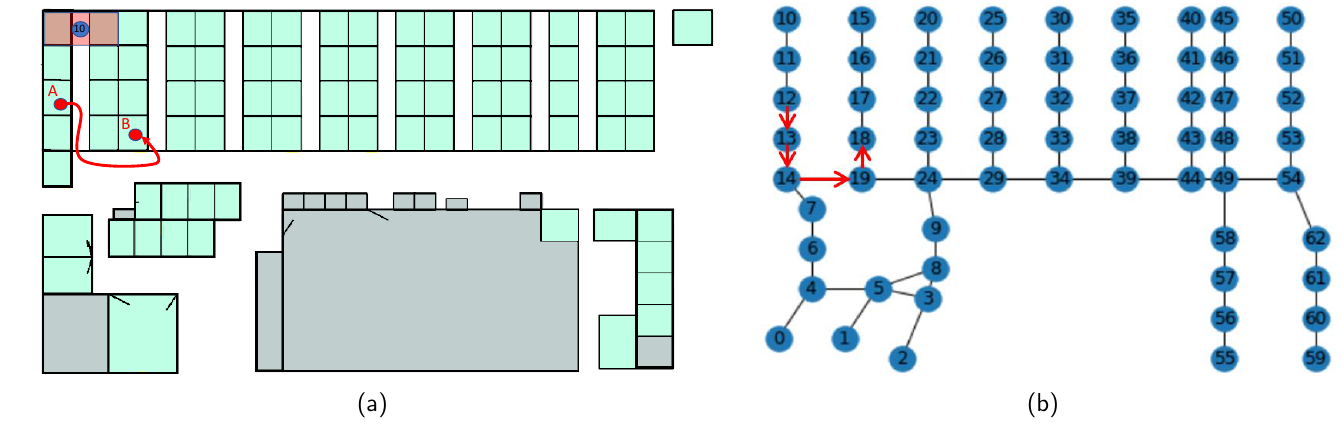
Figure 3. Construction of the indoor navigation graph: ( a ) Floor plan. ( b ) Indoor navigation graph. Next, semantic labels need to be assigned to the trajectory points to compute the distance between indoor trajectories using LCSS_IS. Each point is matched with a label using the point coordinates and entity labels in indoor spaces. A list of semantic labels, defined in the MIT Badge and the sCREEN datasets, is shown in Table 1. Table 1. List of semantic labels in